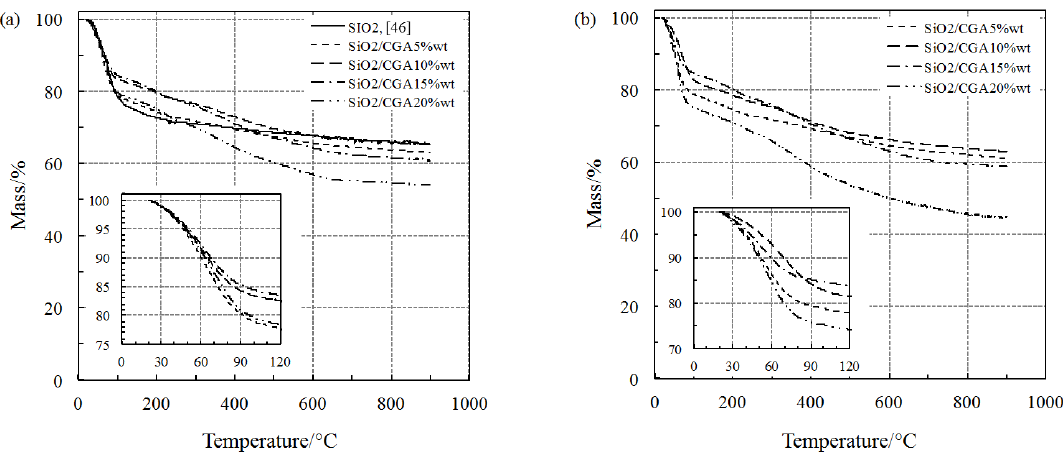
Figure 4. Thermogravimetric (TG) curves of pure SiO 2 and SiO 2 /CGA hybrids at 10°C min −1 under a flowing atmosphere of: nitrogen ( a ); air ( b ).